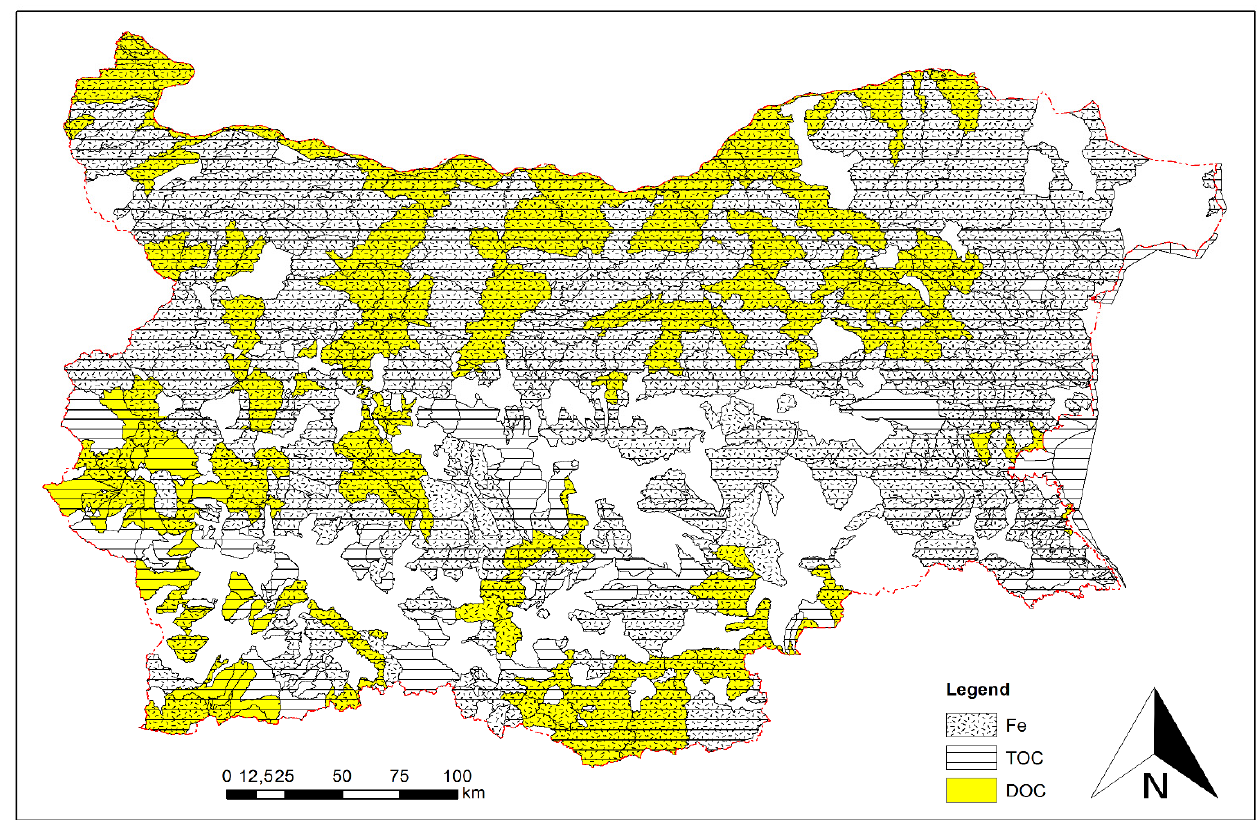
Figure 1. Data availability map.